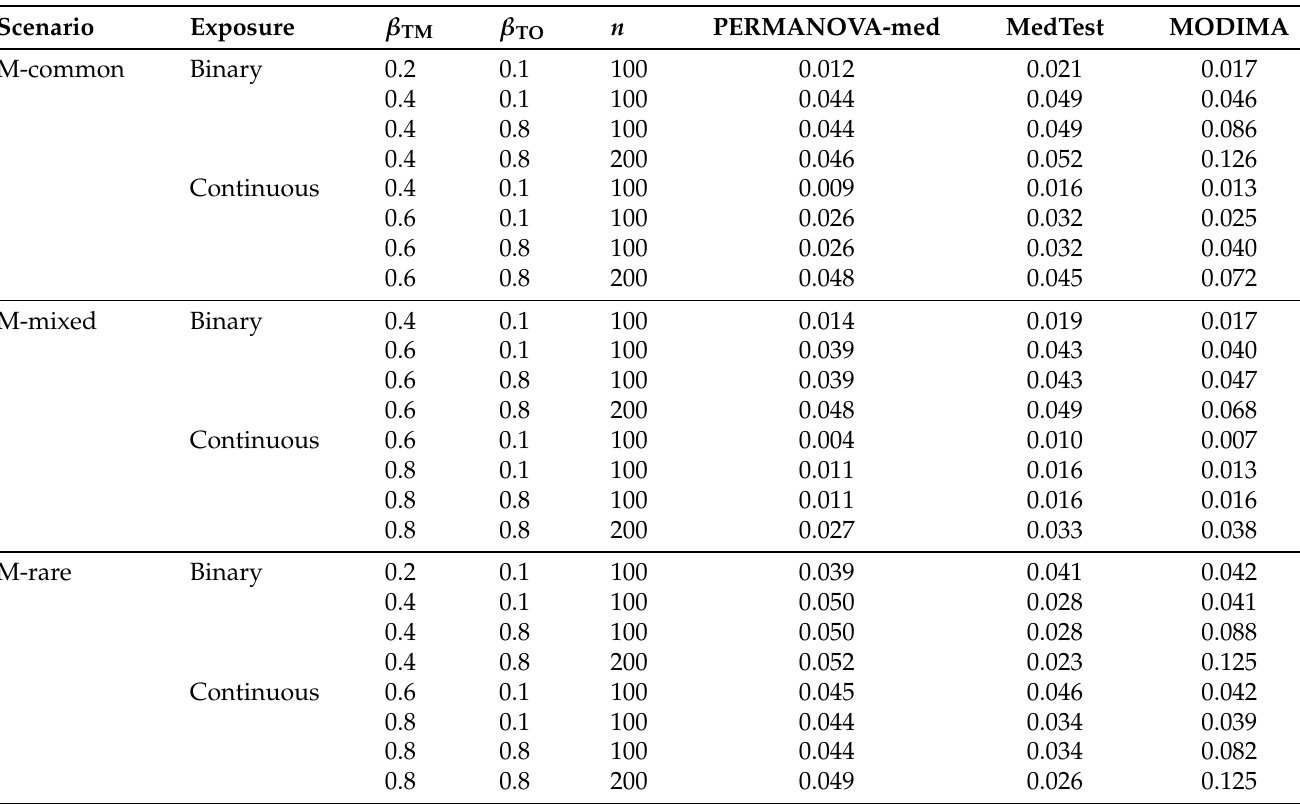
Table 1. Type I error (at the level 0.05) in analysis of simulated data without a confounder.